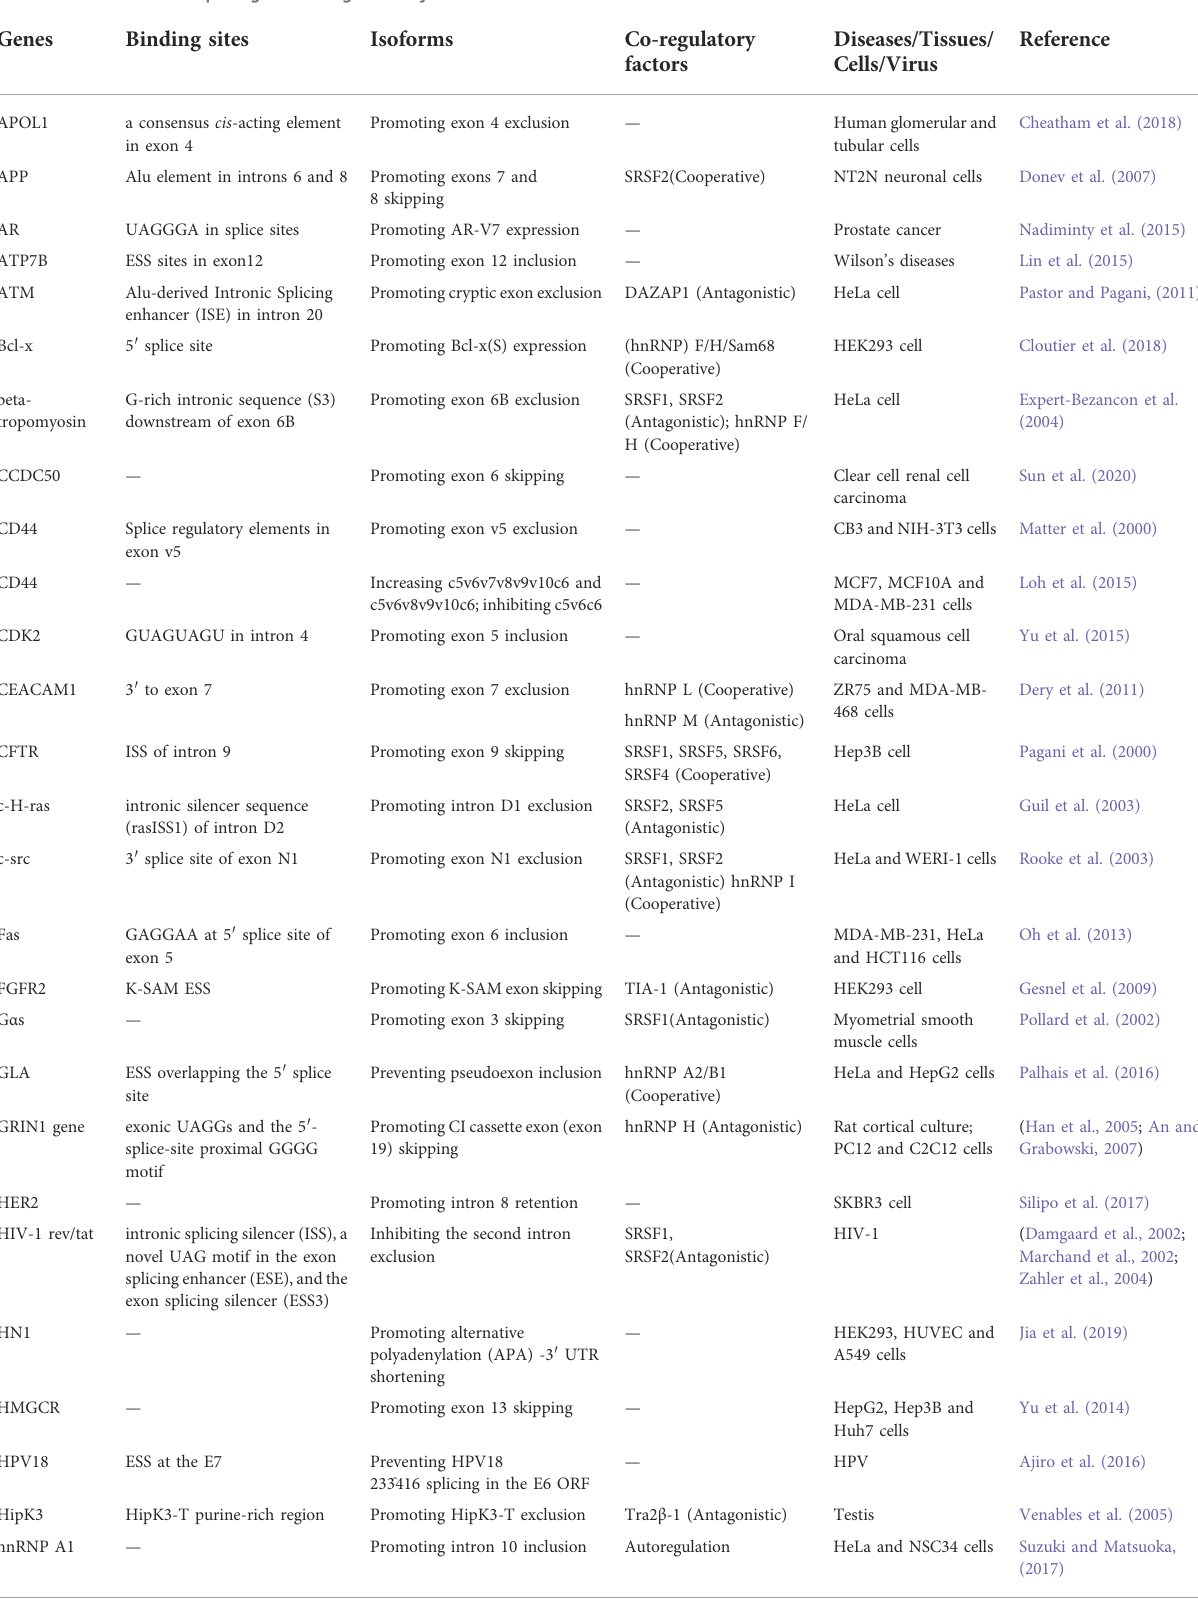
TABLE 1 The alternative splicing events regulated by hnRNP